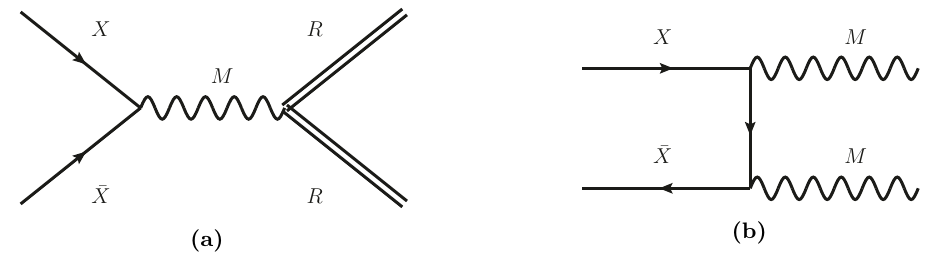
Figure 2. (a) Annihilation of X to dark radiation (represented by double lines) when M This occurs in most of the parameter space we consider. (b) Annihilation of X directly to the mediator when M X M M (cid:29)